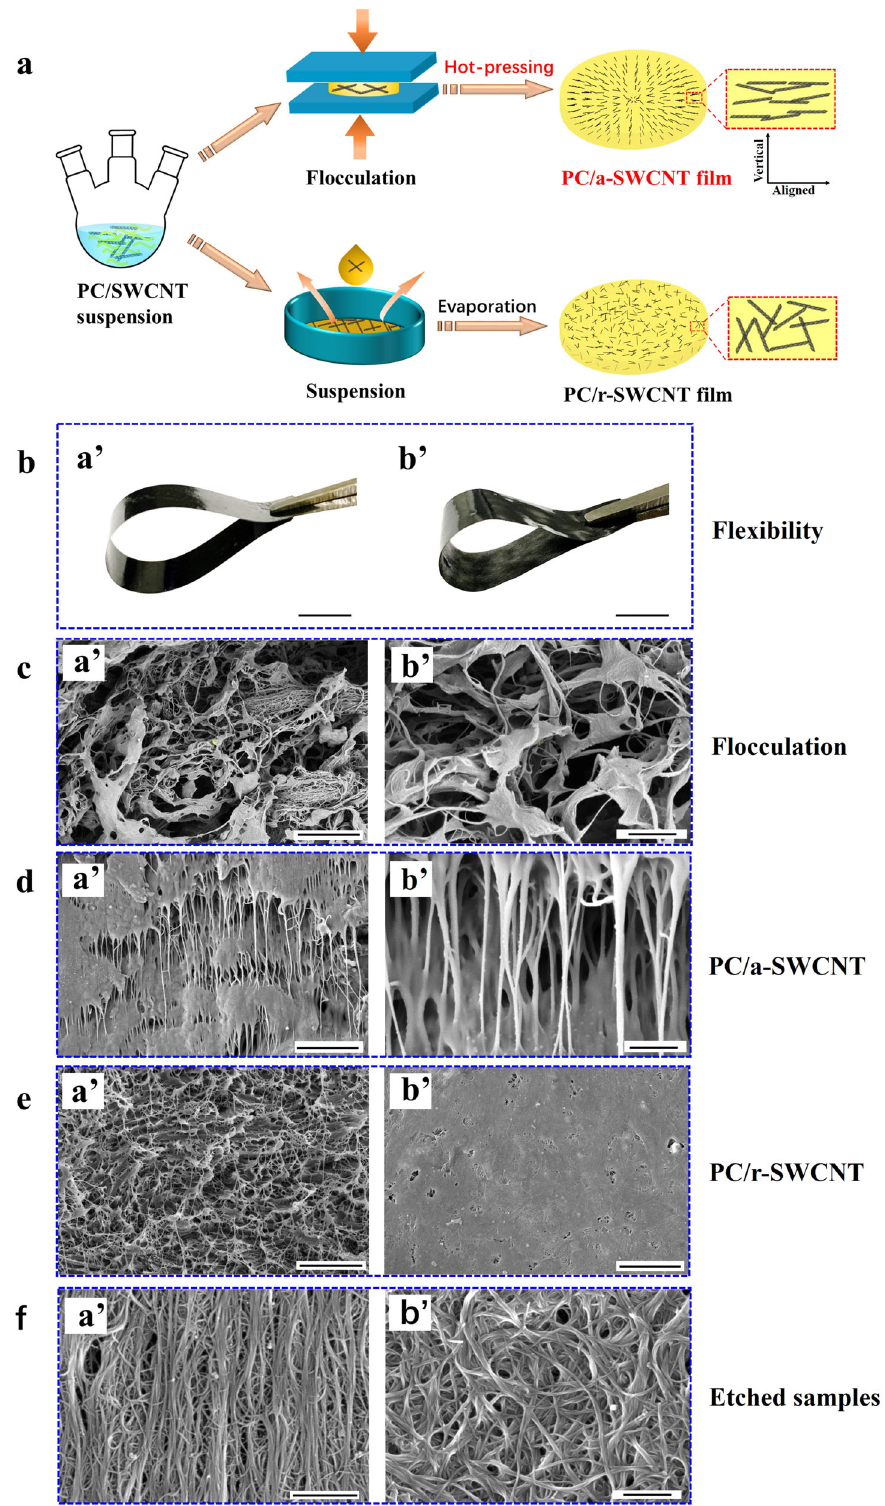
Fig. 1 The preparation and morphology of fl exible TE compsoites. a Schematic illustration of the preparation procedures for PC/a-SWCNT and PC/r-SWCNT fi lms; b Digital photographs showing excellent fl exibility for PC/a-SWCNT fi lm (a ’ , scale bar 1 cm) and PC/r-SWCNT fi lm (b ’ , scale bar 1 cm); c SEM images for the fl occulation (a ’ , scale bar 5 μ m; b ’ , scale bar 1 μ m); d SEM images for cross section of PC/a-SWCNT fi lm (a ’ , scale bar 5 μ m; b ’ , scale bar 1 μ m); e SEM images for (a ’ , scale bar 5 μ m) cross section and (b ’ , scale bar 5 μ m) surface of PC/r-SWCNT fi lm; f SEM images of etched samples by CH 2 Cl 2 for (a ’ , scale bar 1 μ m) PC/a-SWCNT and (b ’ , scale bar 1 μ m) PC/r-SWCNT fi